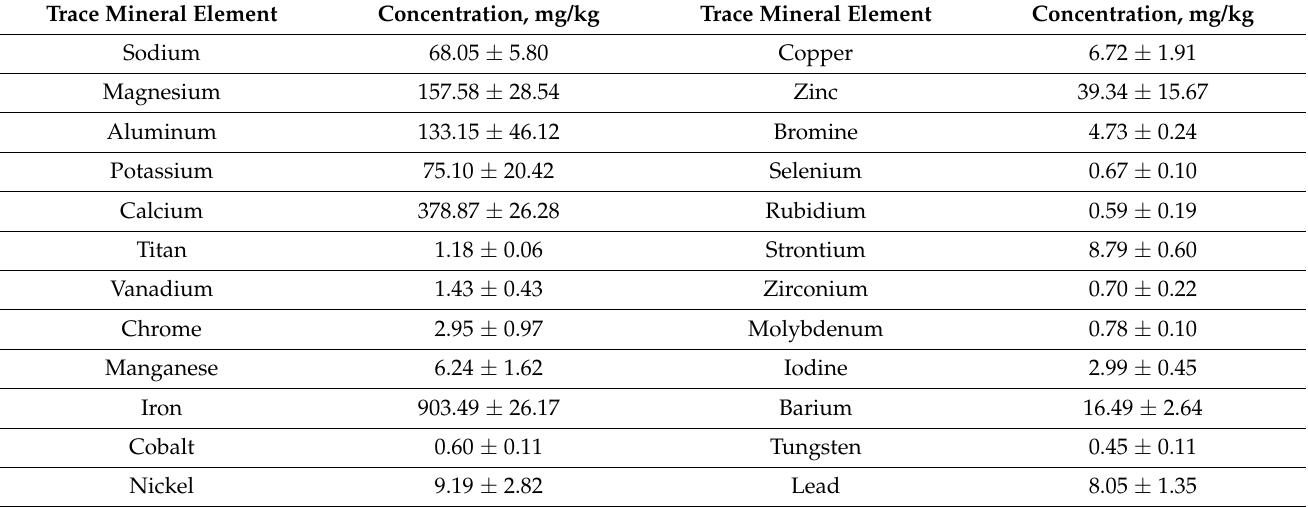
Table 3. The content of minerals in the rock shungite mined in the Republic of Karelia